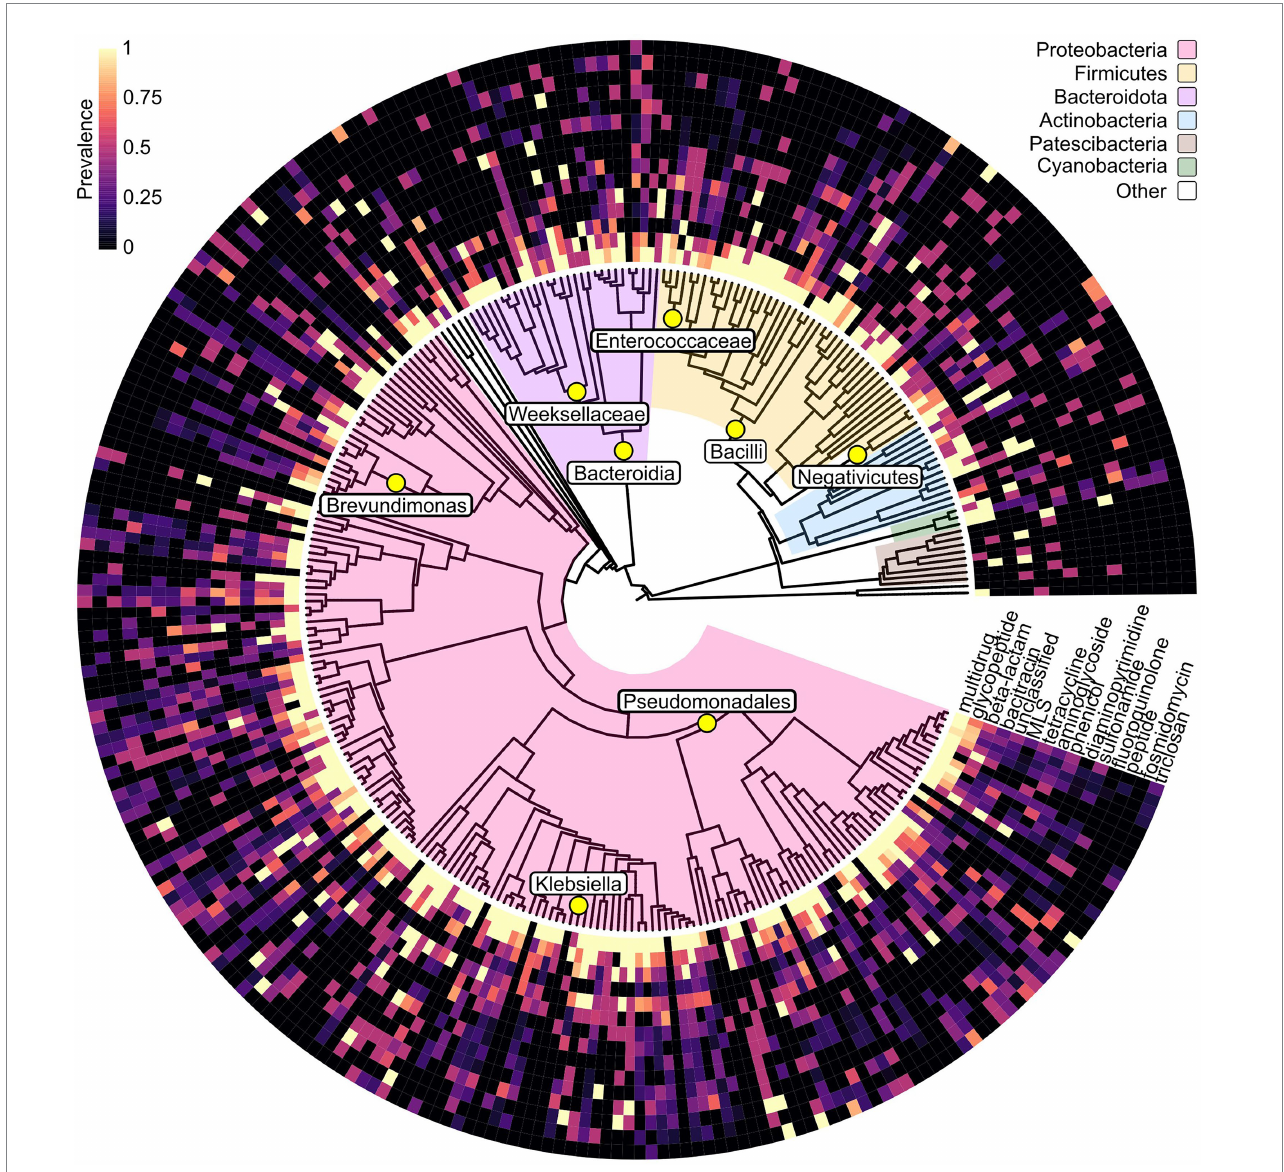
FIGURE 4 A phylogenetic tree of the urban gOTUs based on their GTDB-tk taxonomy. Tree branches are colored based on their phyla. The surrounding heatmap shows per cluster the prevalence of ARGs belonging to the 15 most prevalent ARG classes in the MAGs belonging to each gOTU. Some gOTUs were identified by GTDB-tk to belong to the same taxonomic category, and the prevalence was then calculated based on all MAGs belonging to all the affected gOTUs. Yellow circles show the presence of non-randomly distributed ARG classes at the taxonomic level displayed in the tree, and the labels show the corresponding taxons. Non-randomness was determined with Normalized Mutual Information (NMI) > = 0.5 and chi-squared p -value <0.05. Table 3 lists the taxons with non-random distributions of ARGs within the listed ARG class, along with the NMI and p